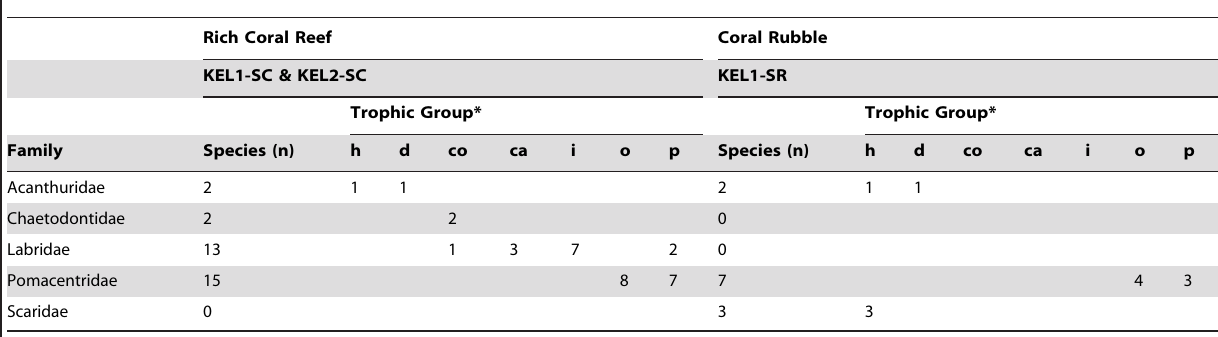
Table 5. Trophic structure of fish families at Kelor Point.